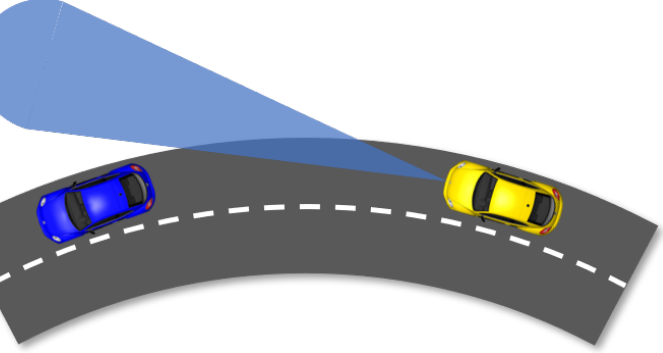
Figure 6. Traffic jam approach scenario with the blue target vehicle and the yellow ego vehicle equipped with a radar sensor.